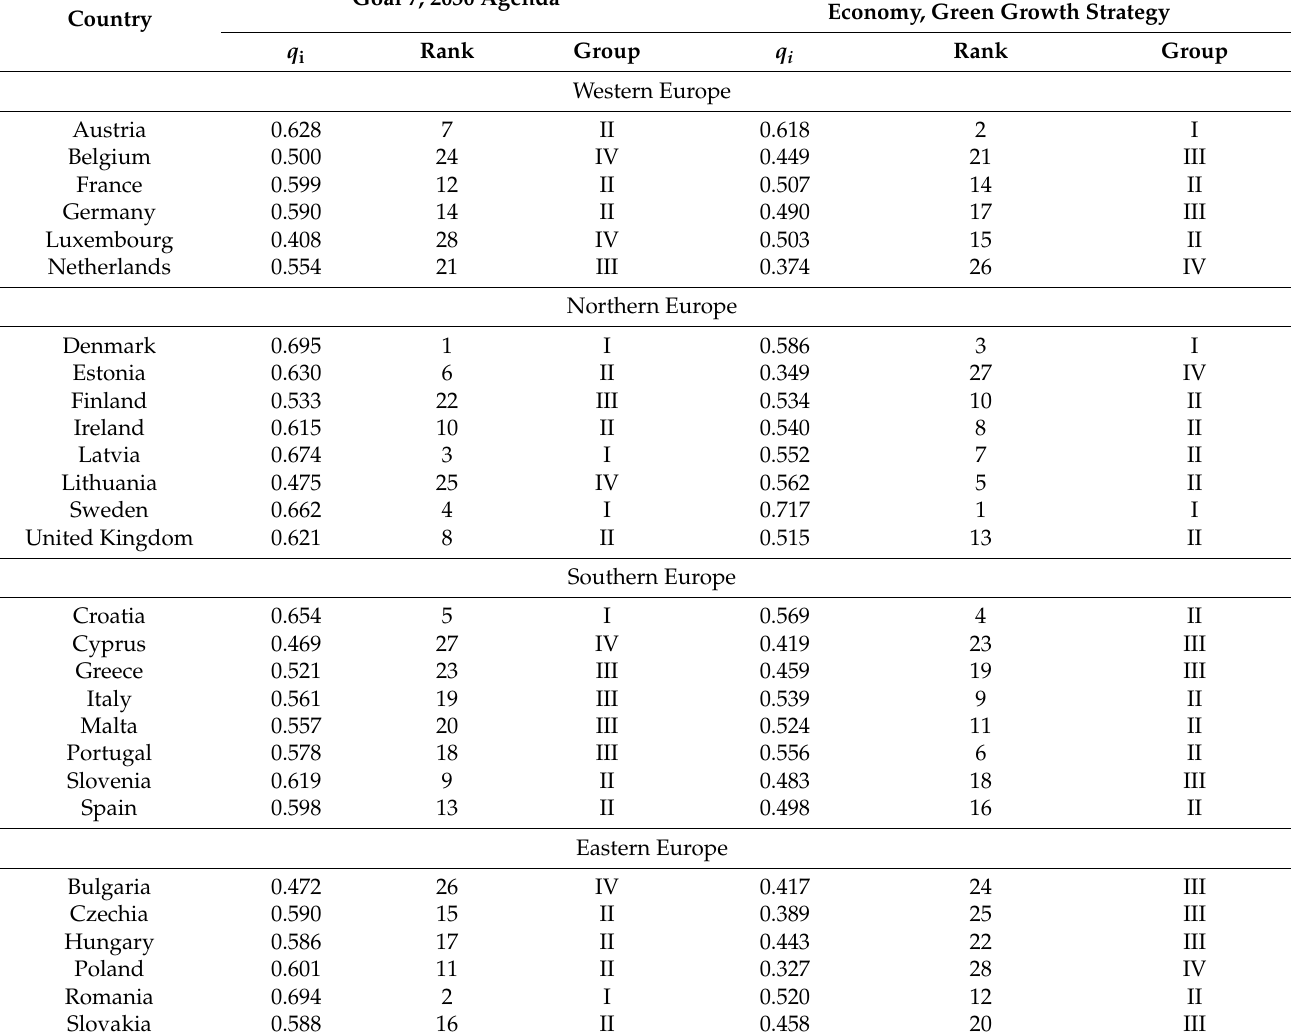
Table 3. Ranking of European Union countries in 2018 due to Goal 7, 2030 Agenda, and the environmental and resource productivity of the economy of Green Growth strategy.